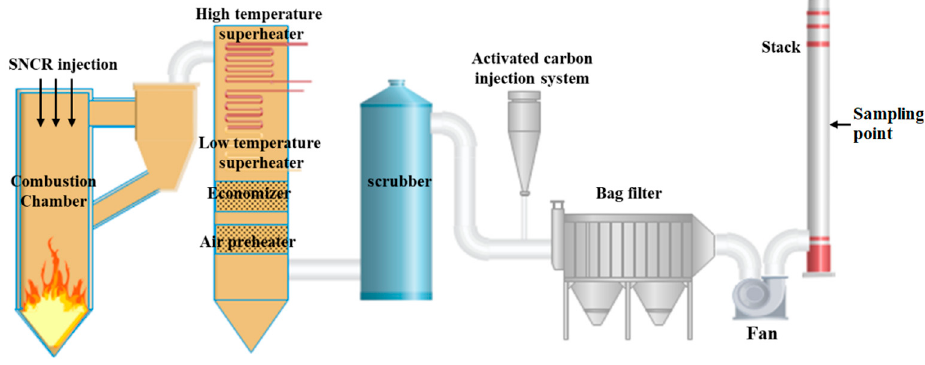
Figure 1. Schematic diagram of the MSW incinerator: sampling point at the stack.